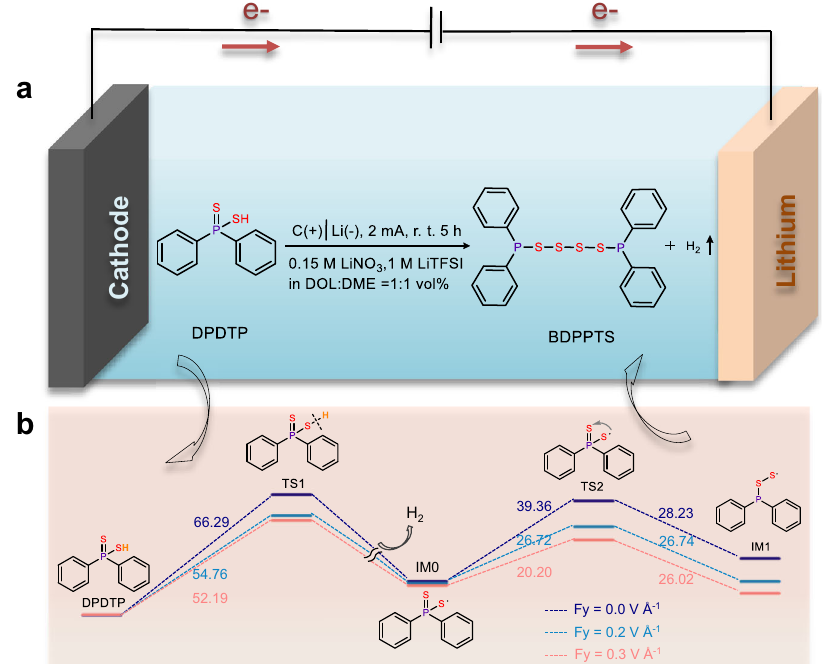
Fig. 1 Electrochemical synthesis and reaction process simulation of BDPPTS. a Synthesis of 1,4-bis(diphenylphosphanyl)tetrasul fi de (BDPPTS) by electrochemical oxidation of diphenyl dithiophosphinic acid (DPDTP). b Proposed reaction process under external electric fi eld: energy pro fi les (in kcalmol − 1 ) for the electrochemical oxidation of DPDTP leading to the formation of linear organopolysul fi des BDPPTS (Fy = 0.0VÅ − 1 , dark blue lines; Fy = 0.2VÅ − 1 , blue lines; Fy = 0.3 VÅ − 1 , red